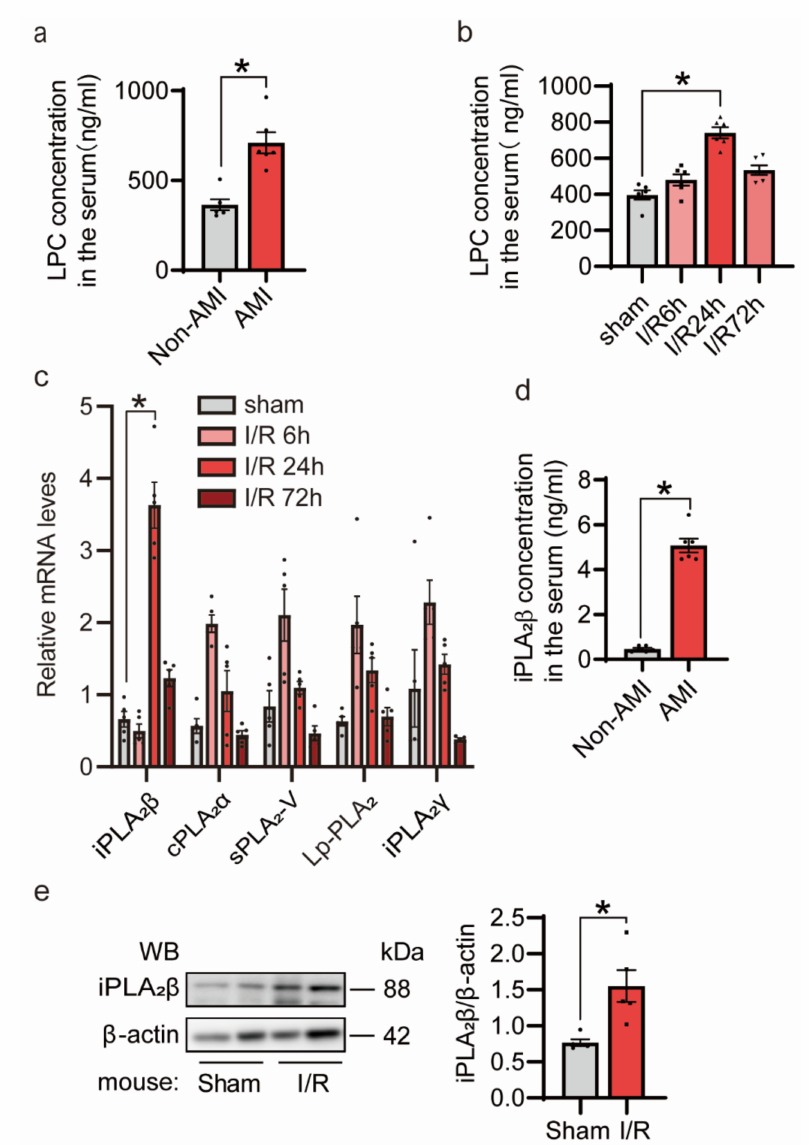
Figure 1. The elevated expression of iPLA 2 β during myocardial ischemia/reperfusion (I/R). ( a ) Lysophosphatidylcholine (LPC) was increased in the sera of the acute myocardial infarction (AMI) patients. Twelve serum samples were collected, six of which were in the AMI group. LPC ELISA was performed to detect the LPC concentration in serum. ( b ) Upregulation of LPC in mouse sera after I/R injury. Mice at 12–14 weeks of age were subjected to myocardial ischemia for 30 min, followed by reperfusion for 6, 24, 72 h. Serum samples were collected, and LPC ELISA was performed to detect the LPC concentration. n = 6 per group. ( c ) The mRNA level of phospholipase A2 in mouse hearts upon myocardial I/R was detected. Quantitative RT PCR (qRT-PCR) was conducted to measure mRNA level changes, with 18S as an internal control. n = 5 per group. ( d ) iPLA 2 β was upregulated in the sera of the AMI patients. iPLA 2 β ELISA was performed to detect the iPLA 2 β concentration. ( e ) The expression of iPLA 2 β in mouse hearts was increased after I/R. Mice were subjected to myocardial ischemia for 30 min, followed by 24 h of reperfusion. Immunoblot analysis was performed for iPLA 2 β . β -actin was used as a loading control. n = 5 per group. Data are represented as mean ± SEM. All experiments were independently replicated in triplicate. * p <